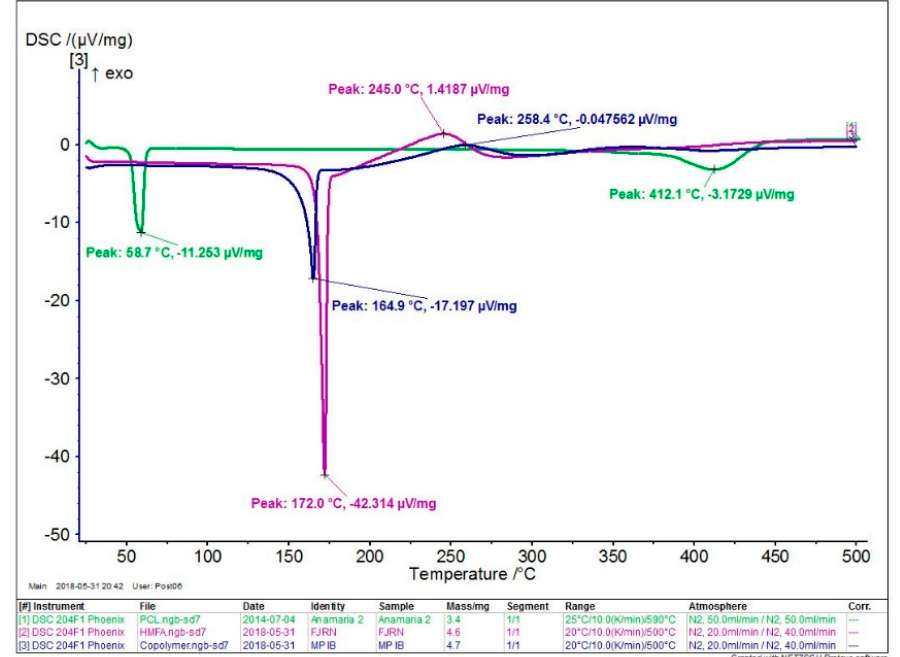
Figure 5. Differential scanning calorimetry characterization (DSC) curves of the HMFA_ECL (blue) copolymers, compared to PCL homopolymer (green) and HMFA monomer (purple).